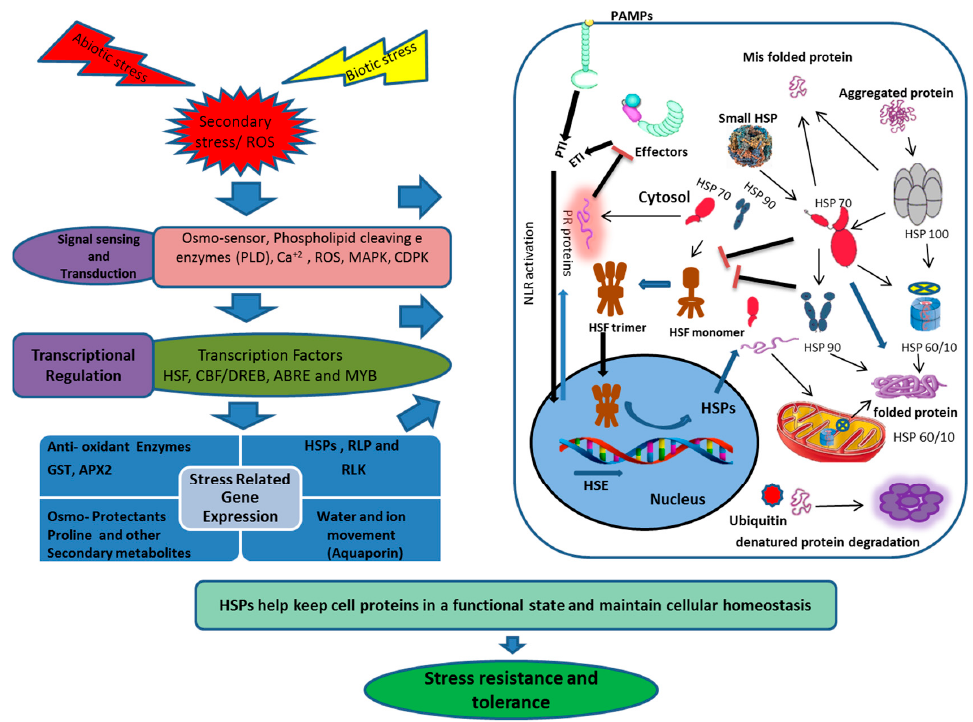
Figure 3. Schematic presentation of the HSP transcriptional regulation, transport and disposal, under biotic and abiotic stresses. The diagram integrates both positive (Arrows) and negative (Bars) regulatory mechanisms. Biotic and abiotic stresses provoke the HSFs through calcium accumulation, recognition of invading pathogen effector proteins, ROS or misfolding and aggregation of cell proteins, which results in activation of HSP and other stress responsive proteins. ROS (Reactive oxygen species), PLD (Phospholipase D), MAPK (Mitogen-activated protein kinase), CDPK (Calcium-dependent protein kinase), HSF (Heat shock factor), CBF (C-repeat binding factor), DREB (Dehydration response element binding protein), ABRE (Abscisic acid-responsive element), MYB (Myeloblastosis), HSP (Heat shock protein), RLKs (Receptor-like kinases), RLP (Receptor-like proteins), PAMP (Pathogenesis-associated molecular pattern), PTI (Pattern-triggered immunity), ETI(E ff ector-triggeredimmunity)NLR(Node-like receptor protein), GST (Glutathione-s-transferase), APX2(Ascorbate peroxidase